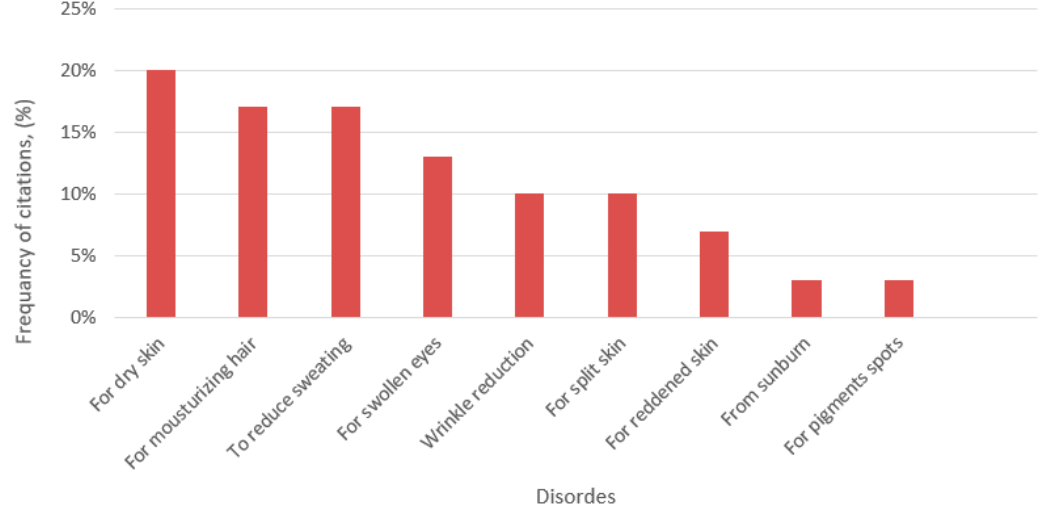
Figure 6. Ethnopharmaceutical usage for cosmetics.